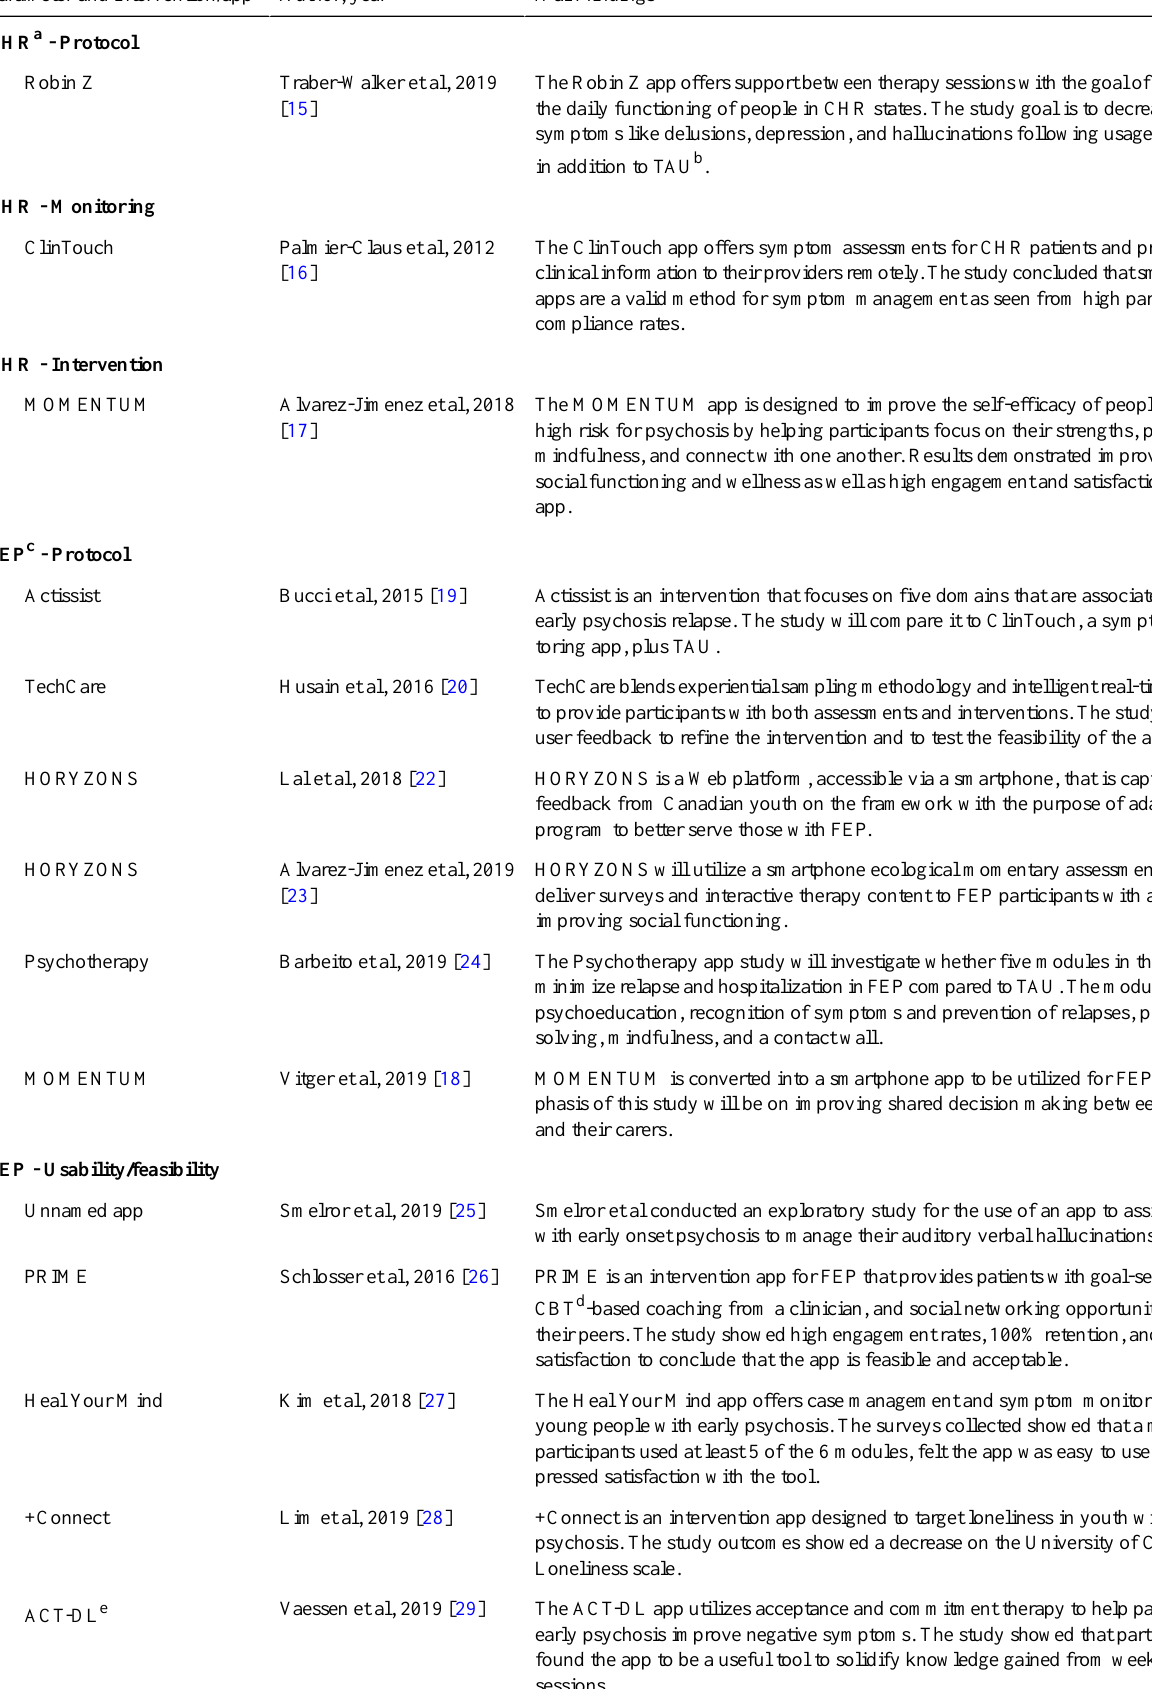
Main findingsAuthor, yearParameter and